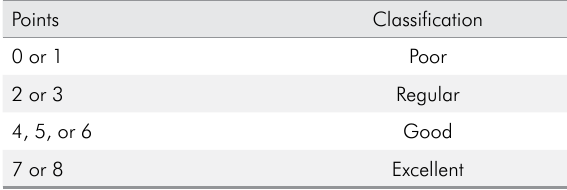
Table 1. Classification of referral letters according to the